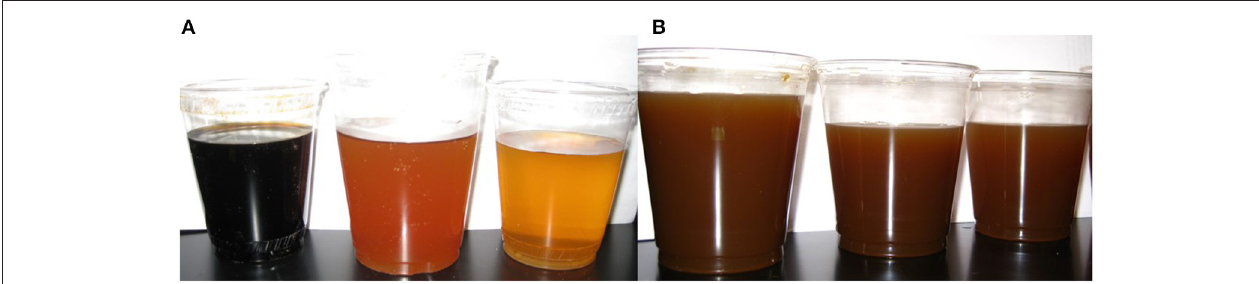
FIGURE 2 | Coloring excipient test and final CAP matching evaluation. (A) Three different coloring agents were dissolved in 8 oz. of water and compared against one another for color matching with CAW. (B) 0, 2, and 4g CAP, containing the selected coloring agent and additional excipients for flavor matching, dissolved in 8 oz. of warm water.